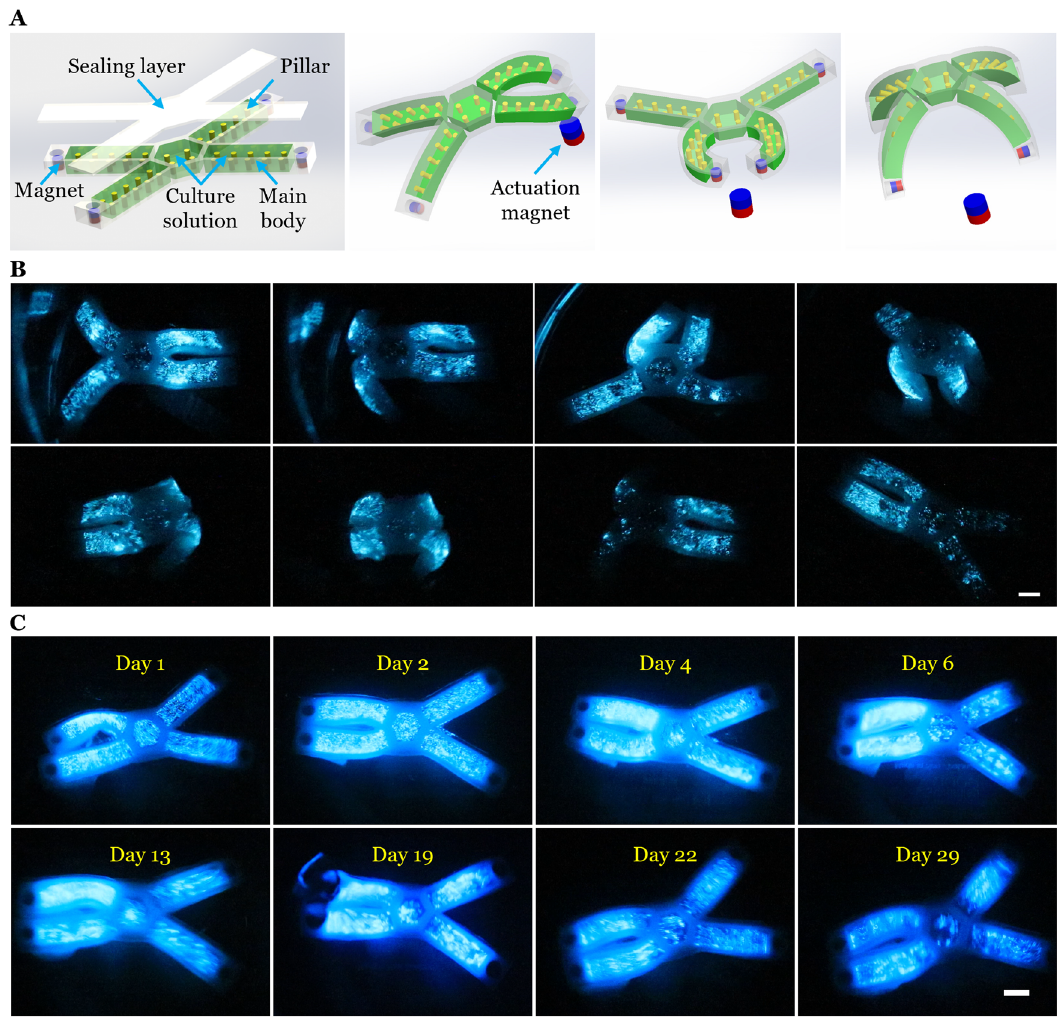
Fig. 7 An untethered magnetically controlled soft mechanoluminescent robot with a closed system. A Schematic of an untethered tetrapod-like soft robot that was controlled by a remote magnetic stimulus. Permanent magnets were embedded at the end of each leg, which consisted of a chamber with pillars. A transparent sealing layer covered the entire body of the robot. The dino fl agellate culture solution was injected into each leg. The motion of the robot was controlled by placement of an actuation permanent magnet. The motion and deformation of the soft robot activated the bioluminescence. B Bioluminescence stimulated by motion of the soft robot under magnetic actuation in seawater. The soft robot achieved varied luminescent patterns depending on the magnetic fi eld-induced deformation mode. Scale bar, 1 cm. C Maintenance of bioluminescence of the magnetically controlled biohybrid soft robot. Bioluminescence was stimulated by motion of the soft robot under external magnetic actuation in seawater for at least 29 continuous days. Scale bar, 1